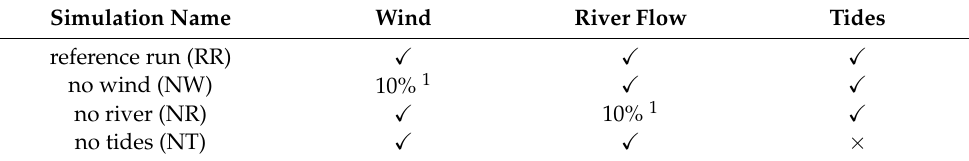
Table 1. Model setup used in the four